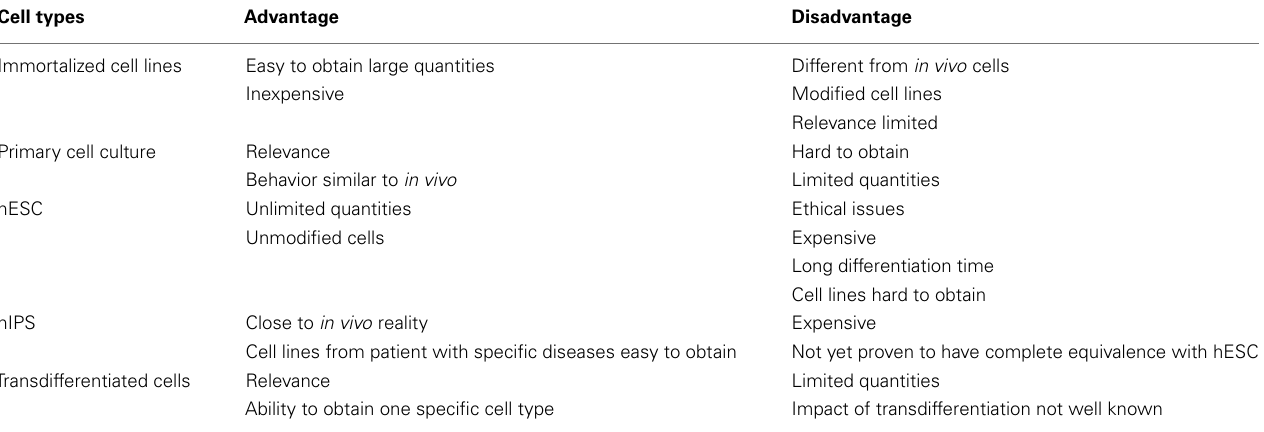
Table 2 | Cell types used in biomedical research with their advantages and inconvenients.